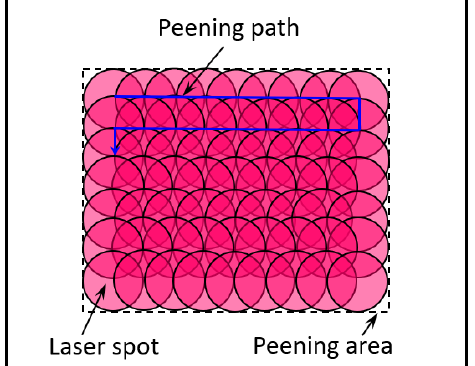
Figure 1. Schematic diagram of peening area and path.